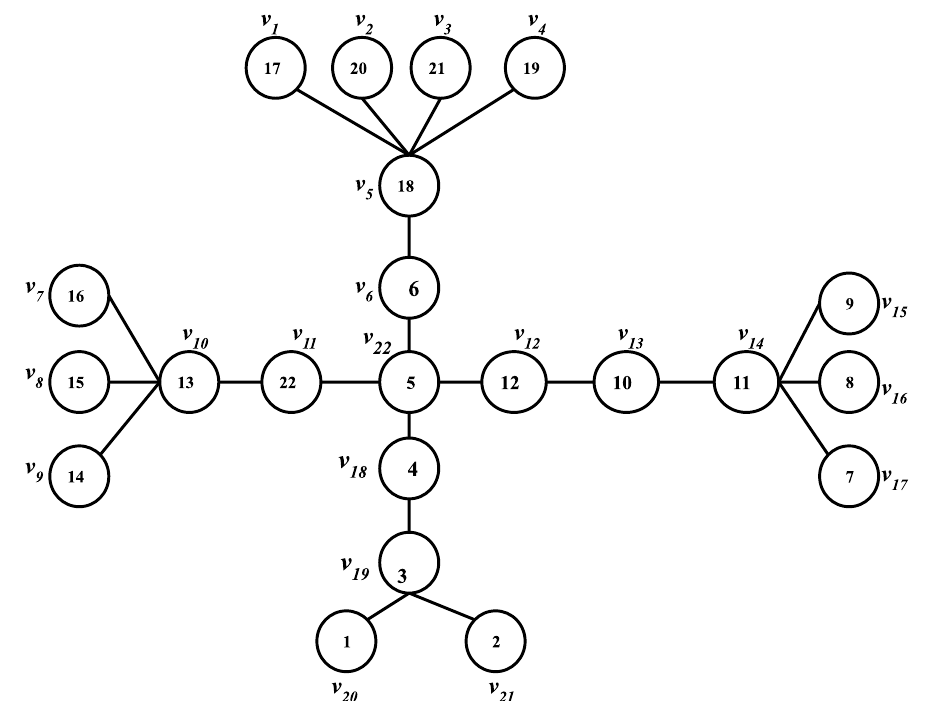
Figure 9. n-Broom with n = 4 and v 22 as the connecting